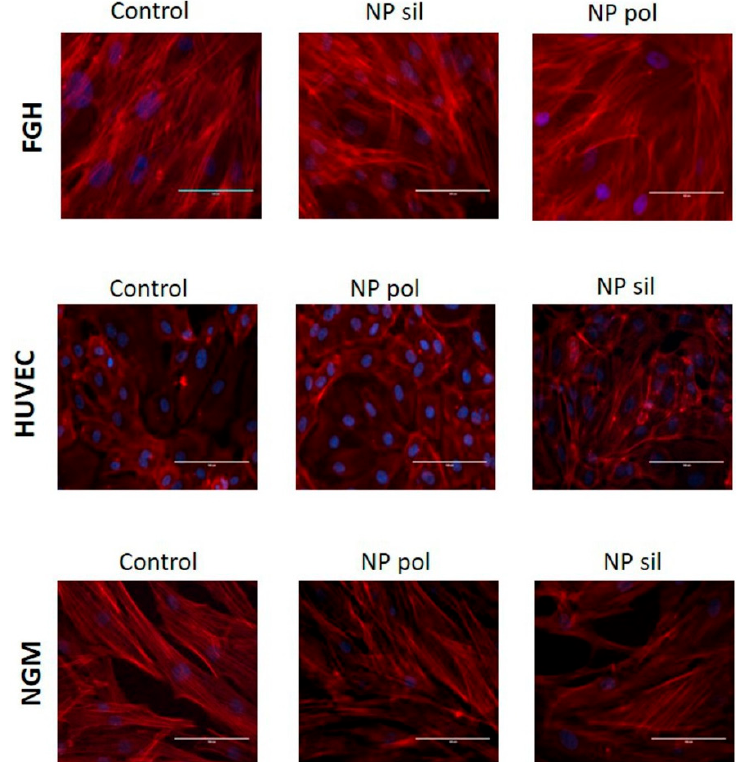
Figure 8. Effects of nanoparticles in non-tumor cells actin cytoskeleton. FGH, HUVEC and NGM cells were incubated with polymeric (pol) or silica (sil) nanoparticles (20 μ g/mL) for 24 h. Filamentous actin was labeled with TRITC-phalloidin and nuclei were stained with DAPI. Representative images from 3 individual experiments were captured at 400 × magnification.